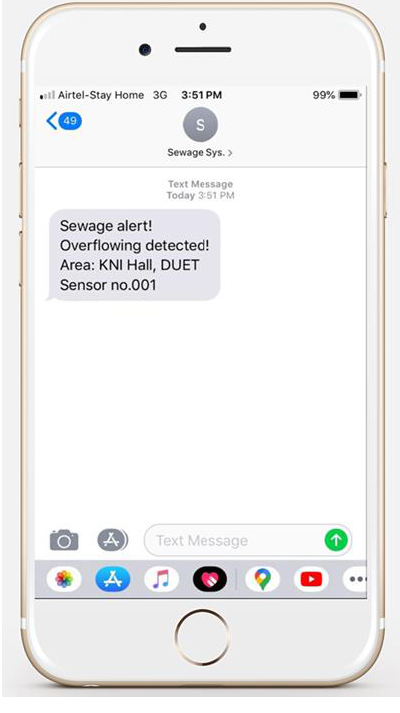
Figure 9. SMS notification when there is an overflow in the system.